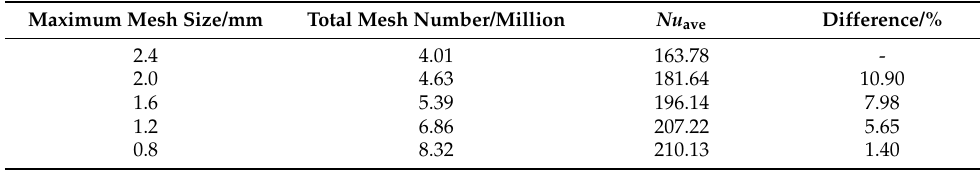
Table 2. Verification of grid independence (Scheme 3: h/H = 0.35, Re =